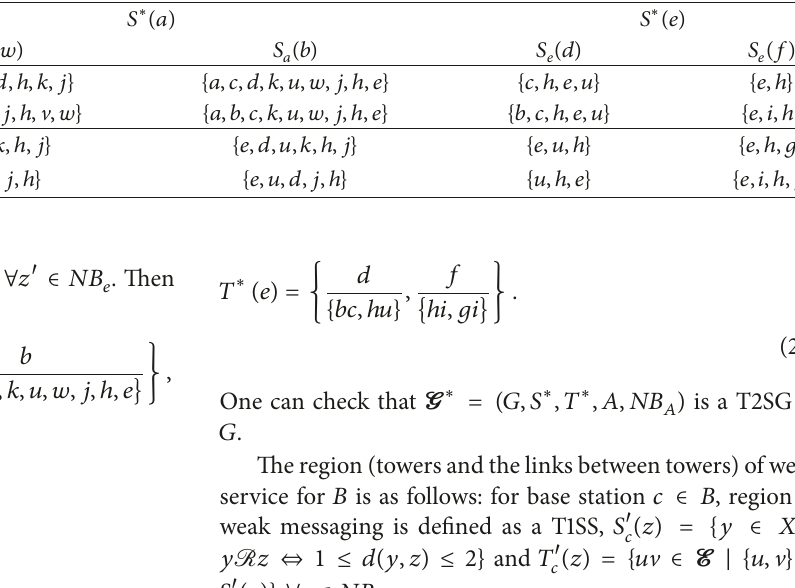
Table 2: (𝐴∧ 𝑋 𝐵) correlation